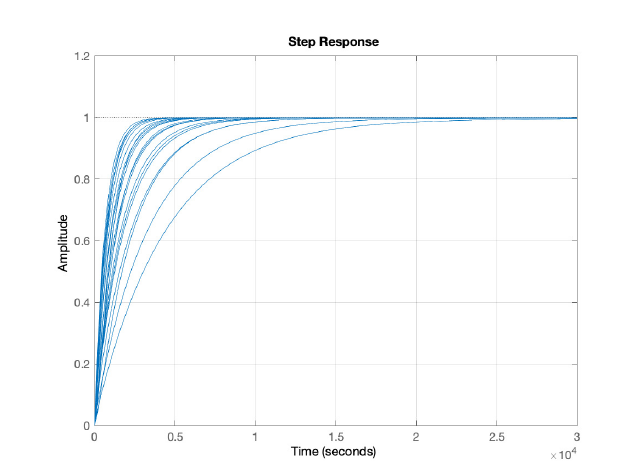
Figure 20. Closed-loop system step response with ¯ C i ( s )